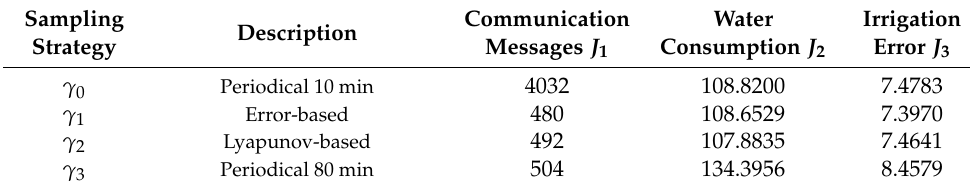
Table 2. Performance evaluation experimental